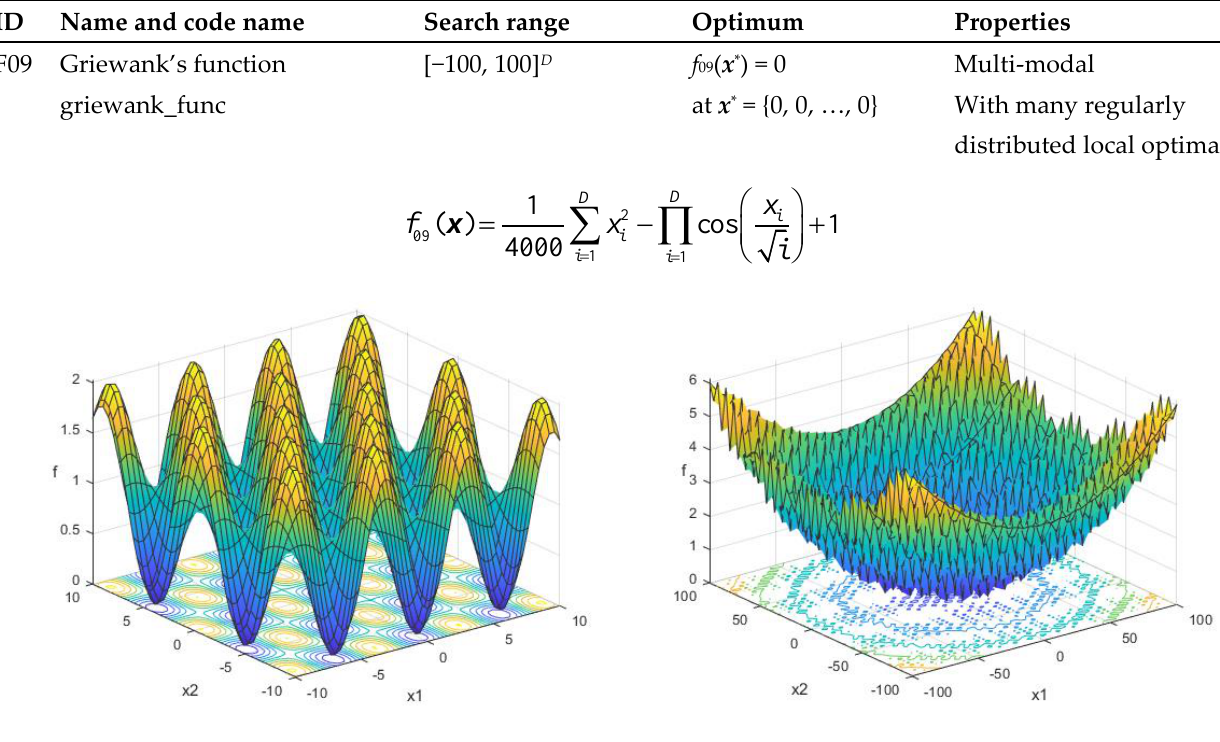
Figure A9. Griewank’s function in two dimensions.